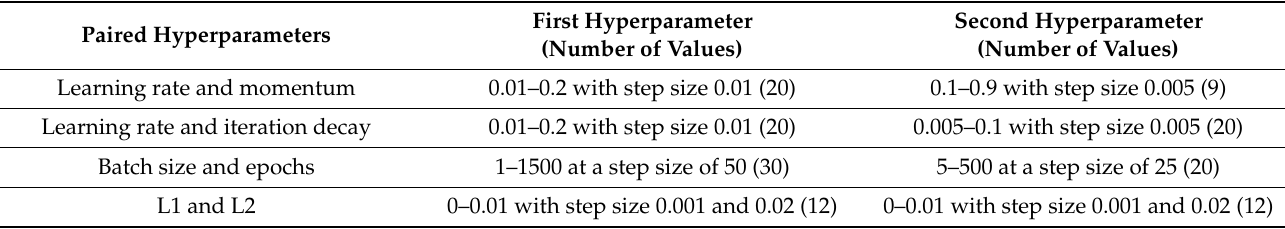
Table 2. Hyperparameters and their values in interactive grid